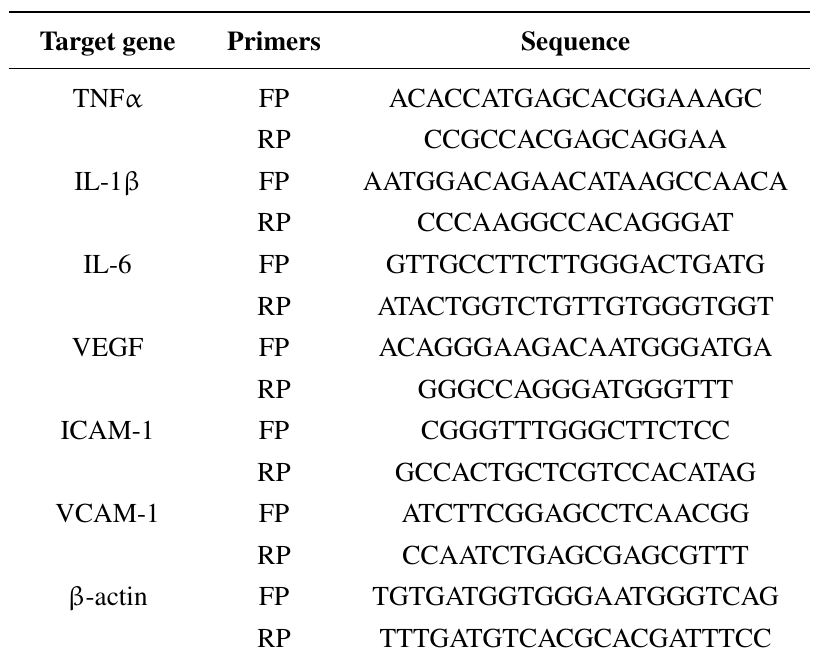
Table 1. Sequences of primers used for real-time Polymerase Chain Reaction (PCR) analysis in this